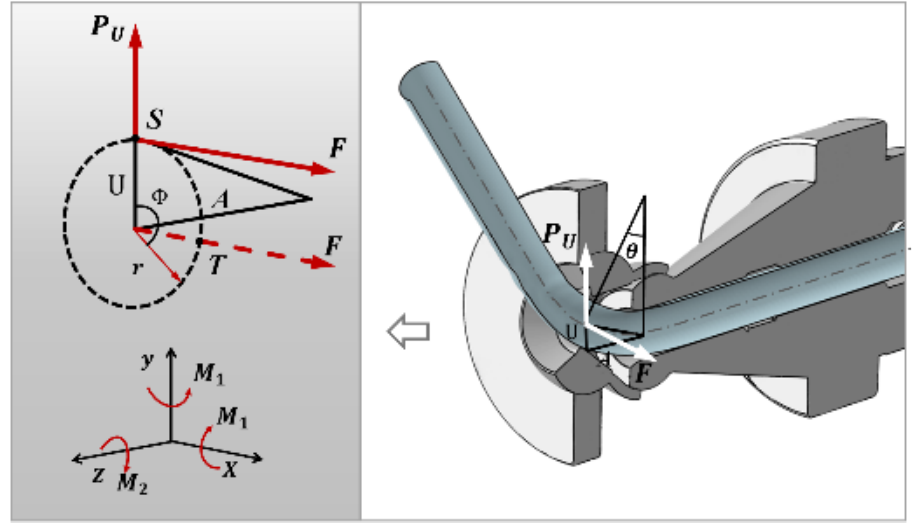
Figure 1. Active deflection mechanical model.